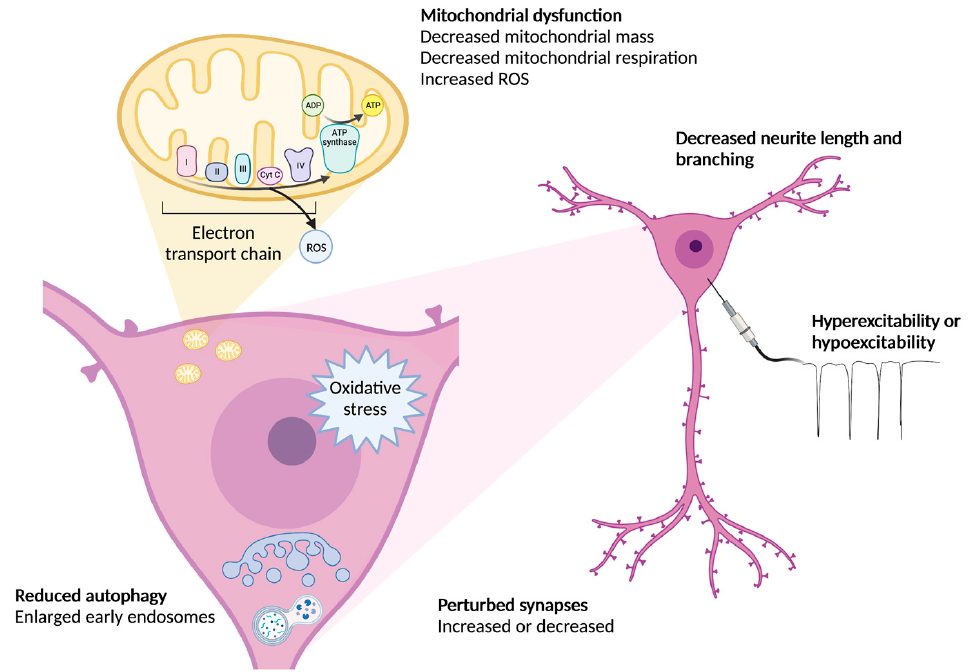
Figure 3. Perturbed organelle and neuron function have been reported in both familial and sporadic AD-iPSC neurons. Mitochondrial dysfunction, reduced autophagy, perturbed numbers of synapses, decreased neurite lengths and branching as well as perturbed excitability have all been reported and reflect known phenotypes shown in the AD brain. However, not all iPSC neurons show these phenotypes and variabilities between cell lines and risk genes/mutations have been noted. Created with BioRender.com. Table 4. Overview of neuronal dysfunction identified in AD-iPSC neurons harboring either familial mutations, sporadic mutations, or from late-onset sporadic AD